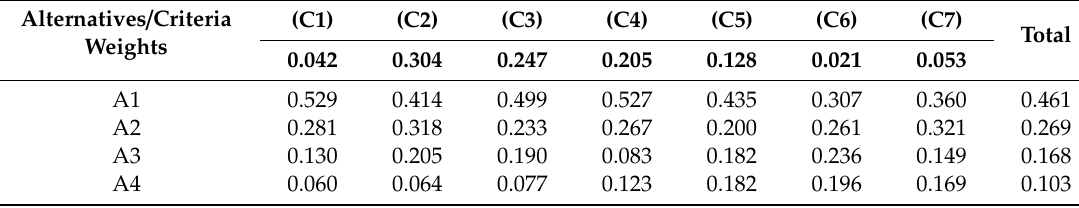
Table 21. Consolidated results of all the alternatives in the light of each